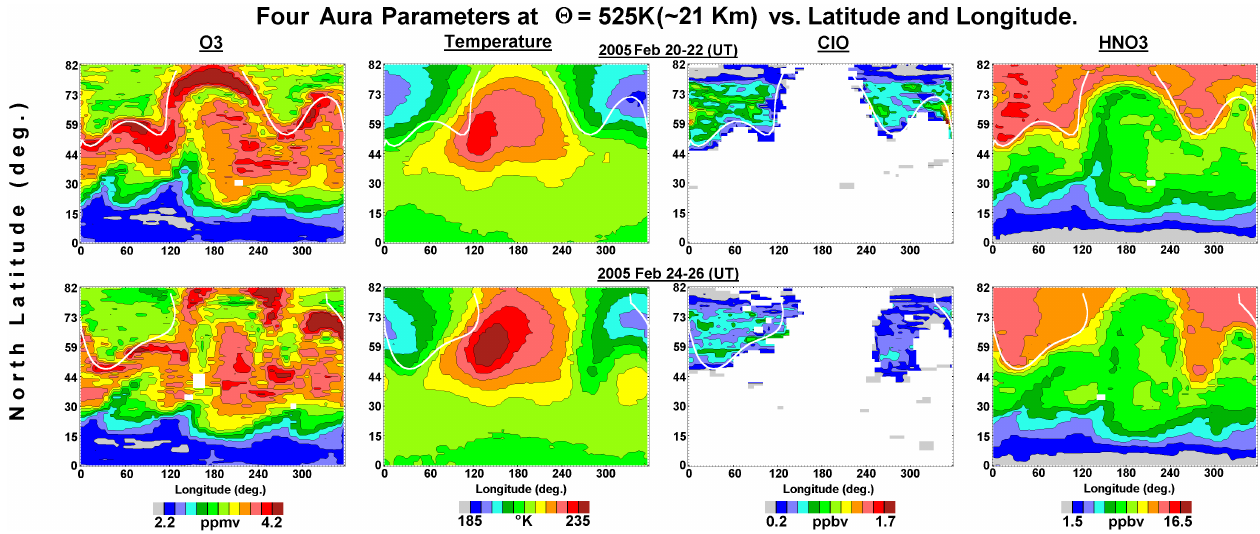
Fig. 14. Polar cylindrical hemispheric contour plots of the 3-day average mixing ratios of ozone, temperature, chlorine monoxide and nitric acid (Aura MLS). These are for two days (21 and 25 February) within the 25 February “warming event” as defined in Sect. 3. The edge of the polar vortex as determined by the Q-diagnostic using MetO (data assimilation model) is shown in white (see